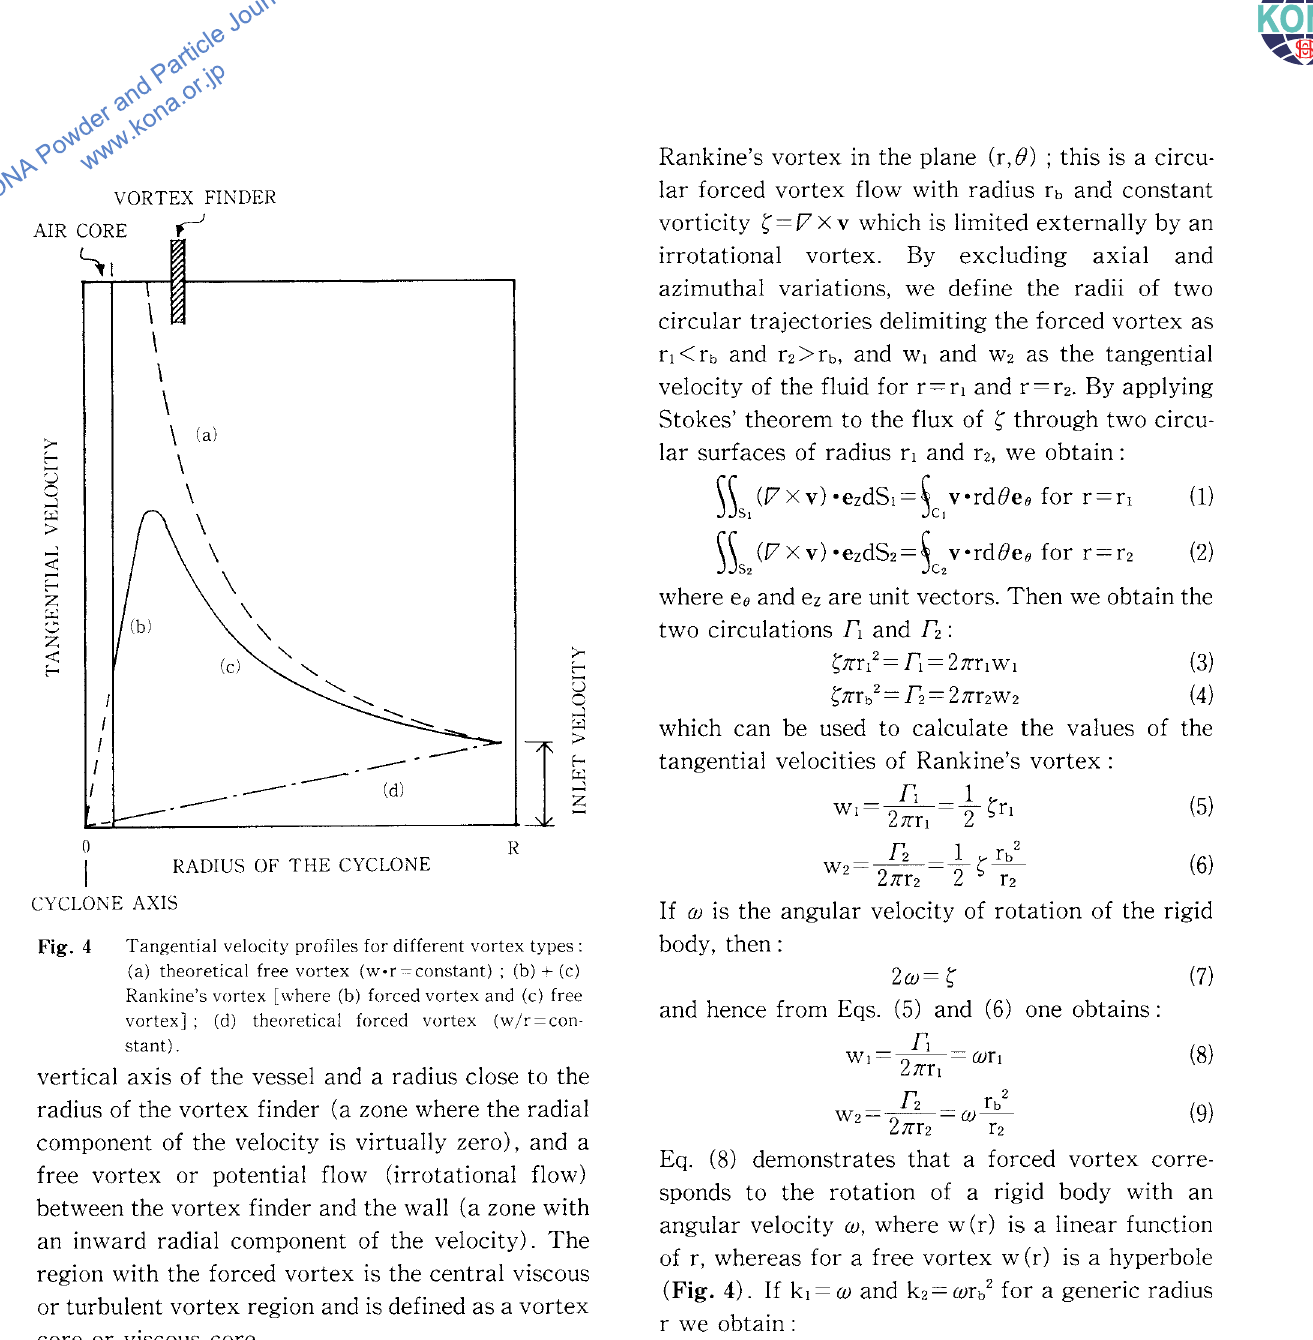
an inward radial component of the velocity). The region with the forced vortex is the central viscous or turbulent vortex region and is defined as a vortex core or viscous